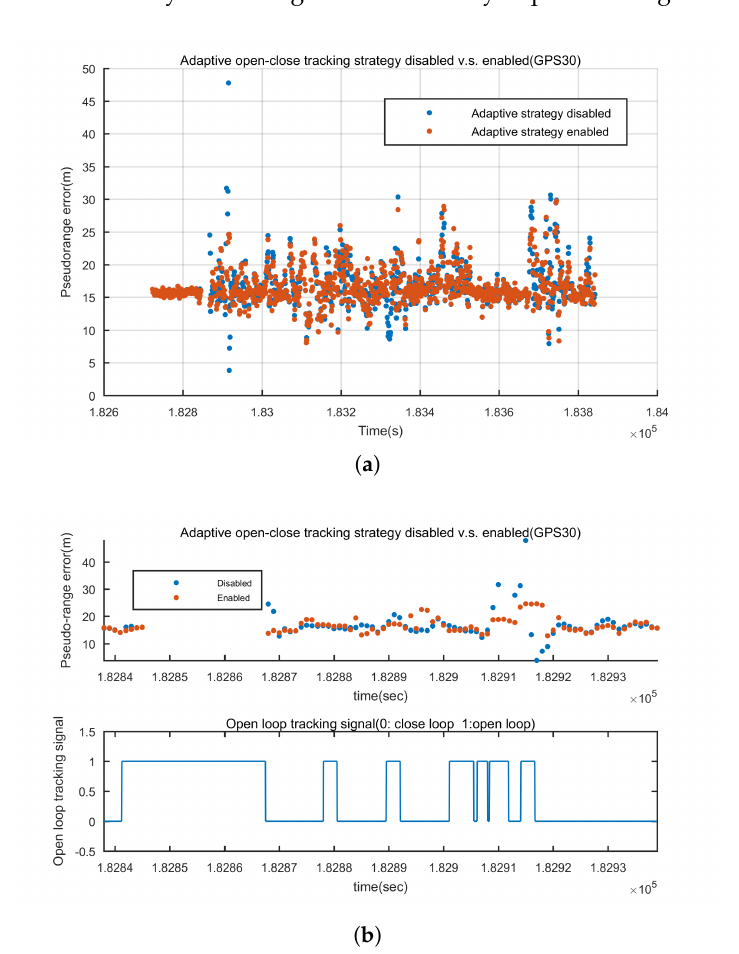
Figure 14. Pseudo-range error before and after applying the adaptive open-close loop tracking strategy of GPS 30 ( a ) Pseudo-range error during the whole experiment ( b ) From 182,840 s to 182,930 s, GNSS signals are frequently blocked and the adaptive open-close loops presented better